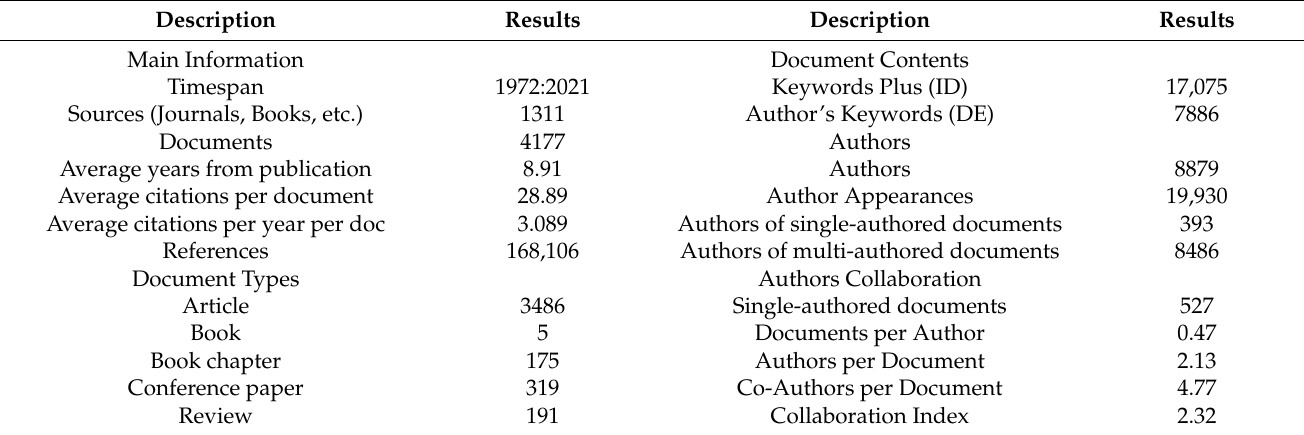
Table 3. Main information and statistics on bibliometric data used in this study